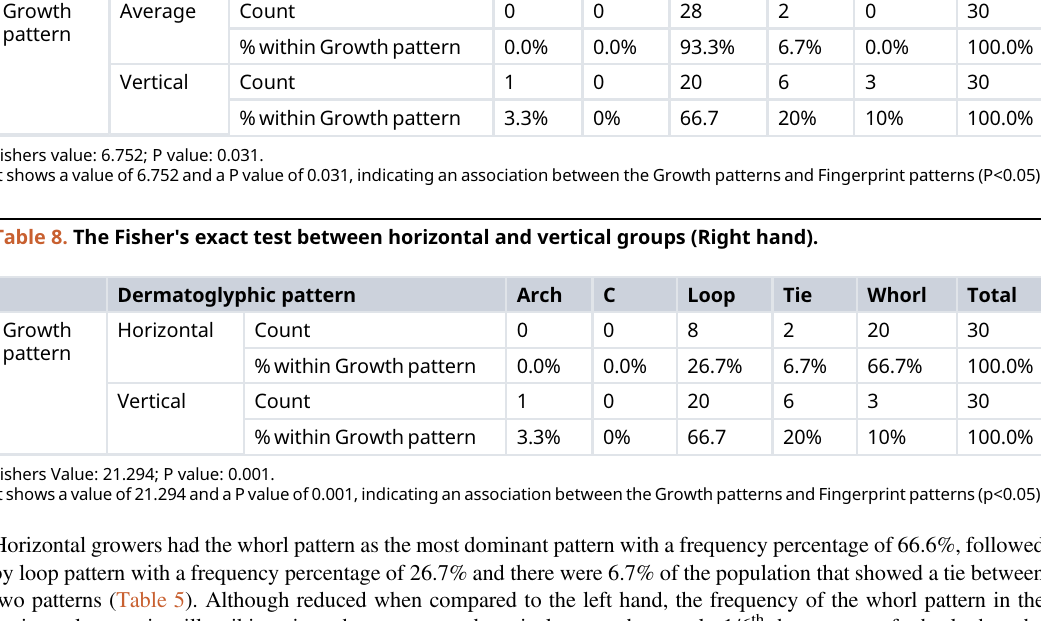
Table 7. The Fisher ’ s exact test between the average and vertical groups (Right hand). Dermatoglyphic pattern Arch C Loop Tie Whorl Total Growth Average Count 0 0 28 2 0 30 pattern %withinGrowthpattern 0.0% 0.0% 93.3% 6.7% 0.0% 100.0% Vertical Count 1 0 20 6 3 30 %withinGrowthpattern 3.3% 0% 66.7 20% 10% 100.0%